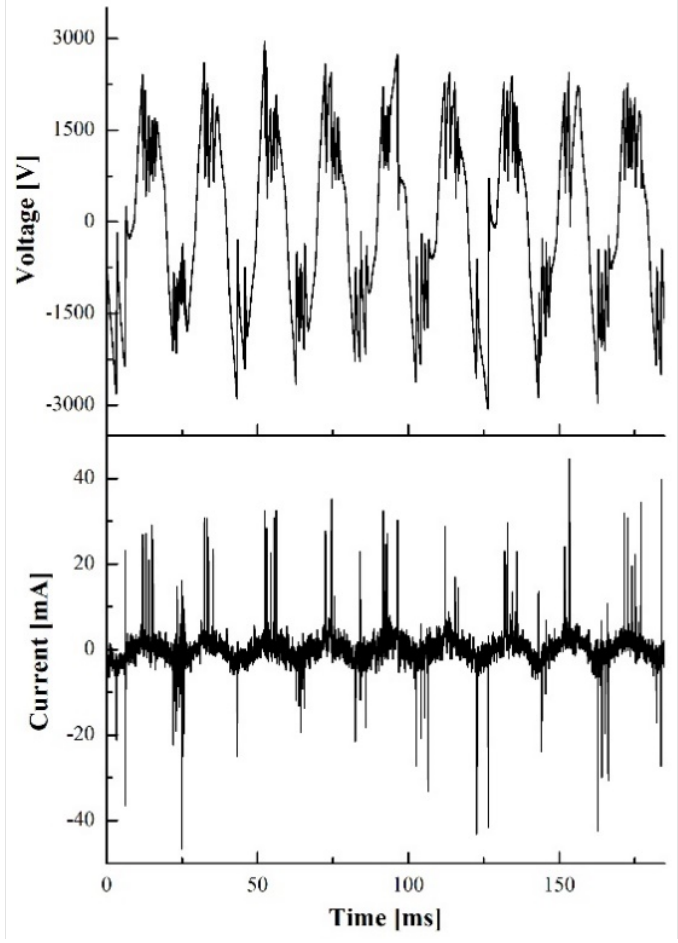
Figure 4. The current and the voltage wave forms for CCL power supply.